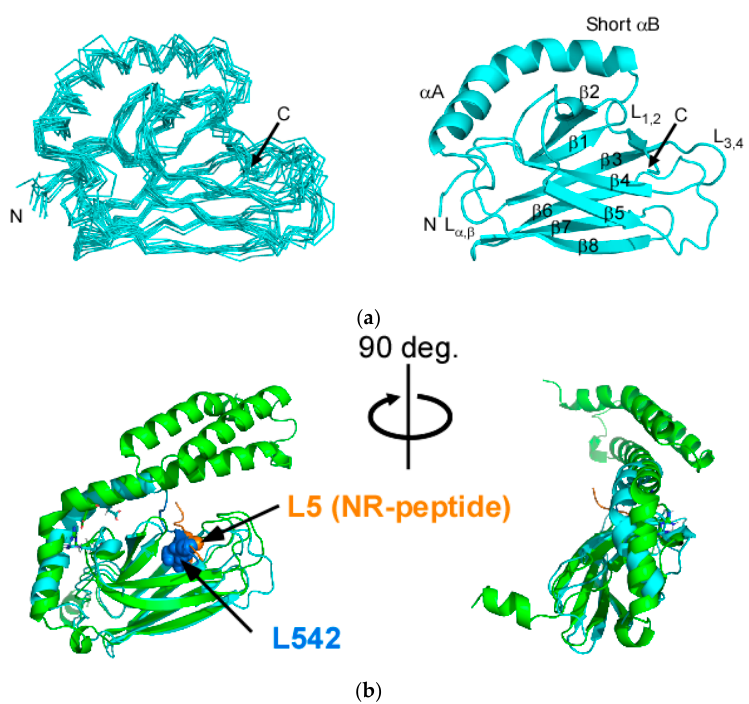
Figure 2. Solution structure of SBD( ∆ CDE) of human Hsp70. ( a ) Superposition of the 10 lowest-energy structures of SBD( ∆ CDE). The N- and C-termini are unstructured (residues 382–392 and 546–564) and were omitted for clarity ( left ). Ribbon representation of the lowest energy NMR structure of SBD( ∆ CDE) ( right ); ( b ) Superposition of the NMR structure of SBD( ∆ CDE) (cyan) and the crystal structure of the NR-peptide-bound SBD of Hsp70 (green) (PDB ID: 4PO2) [15]. Two different views are provided. Key residues in the substrate binding cleft of β SBD are drawn as spheres: L542 in SBD( ∆ CDE) (blue) and L5 in the NR-peptide with the sequence 1 NRLLLTG 7 (orange).